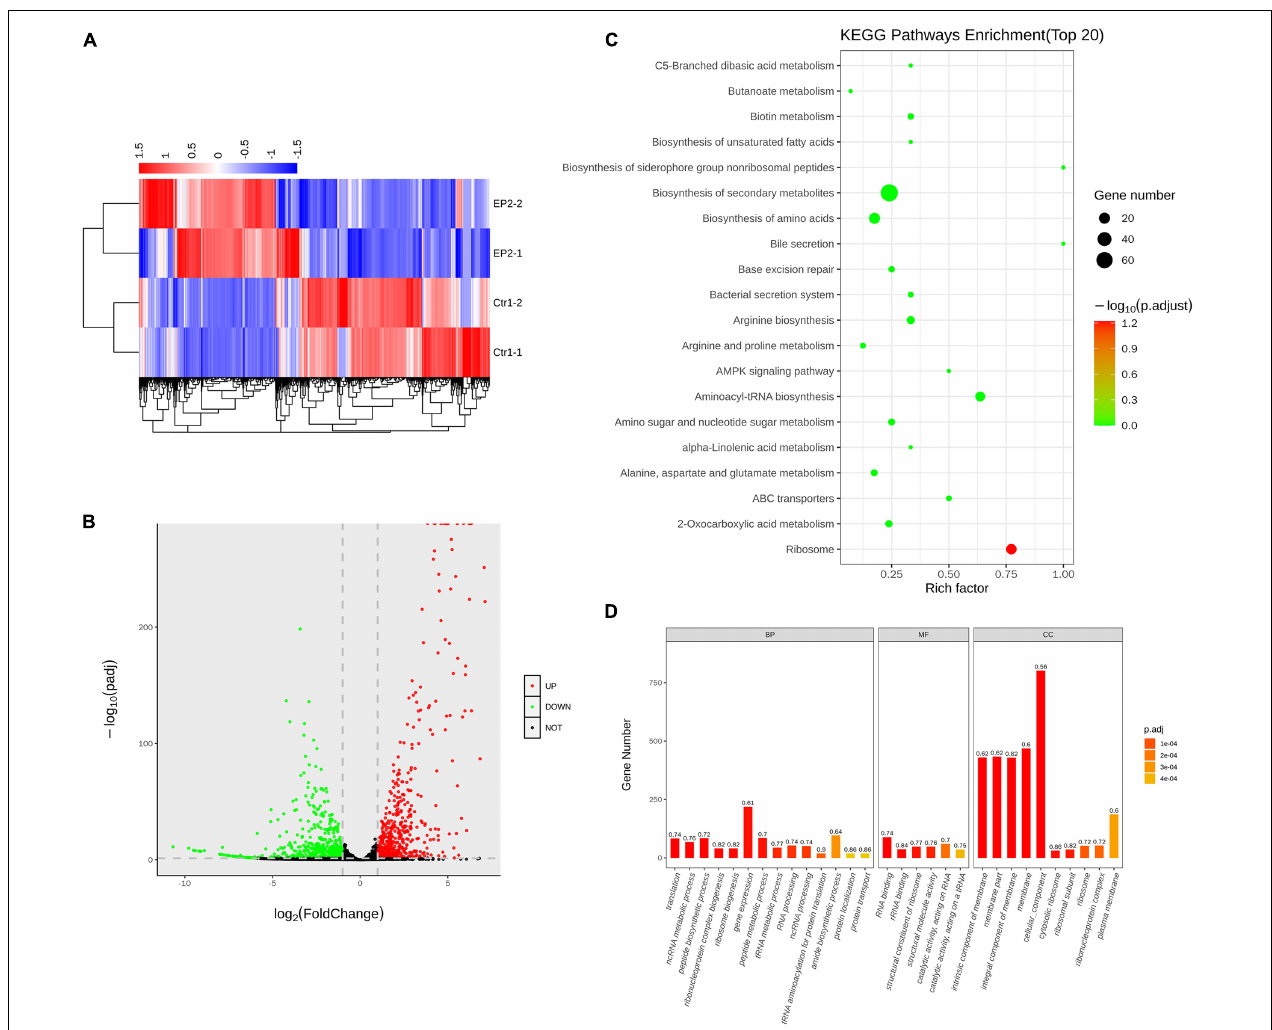
FIGURE 4 | Transcriptome analysis of S. aureus USA300 after treatment with 5 × minimum inhibitory concentration of EP for 1 h. (A) Heat-map of differentially expressed genes. (B) Upregulated and downregulated genes are shown by red and green dots, respectively. (C) Bubble chart of top 20 enrichment genes in KEGG pathways. Dot color indicates the value of adjusted p , and dot size indicates the number of enrichment genes in each pathway. (D) Gene ontology analysis of relative gene expression by whole transcriptome sequencing. Genes were enriched using the cellular component (CC), biological process (BP), and molecular function